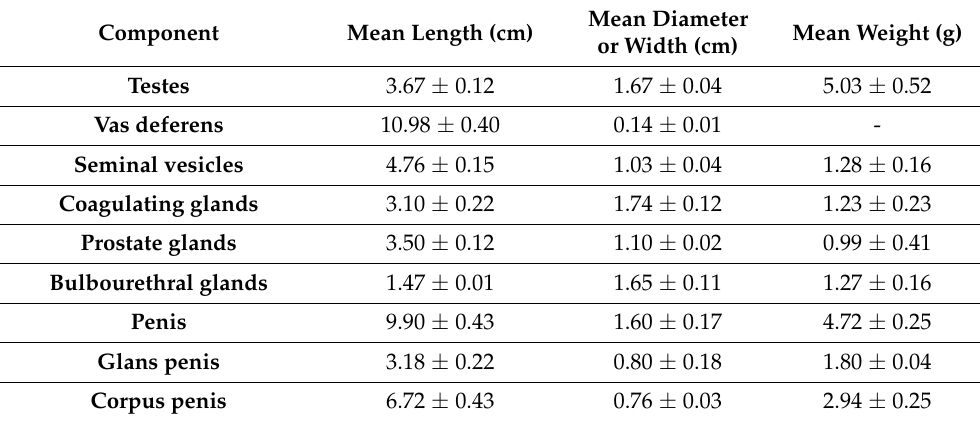
Table 1. Gross measurements of the male reproductive tract of the agouti ( D. leporina ), according to Mollineau et al.